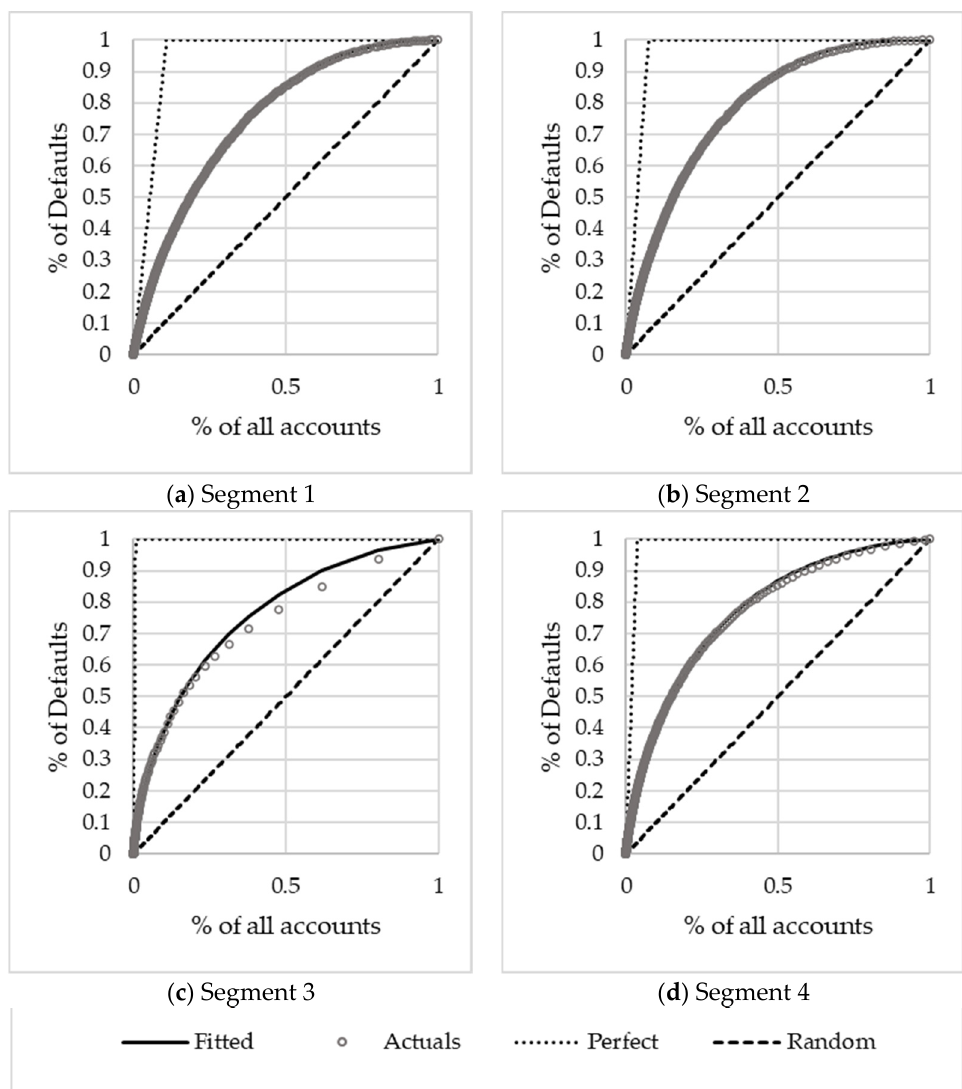
Figure 6. 12 month Lorenz curves.